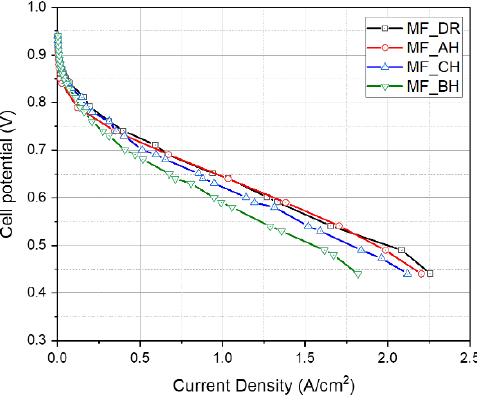
Figure 7. Variation of PEFC voltage with metal foam flow field under various humidification conditions.